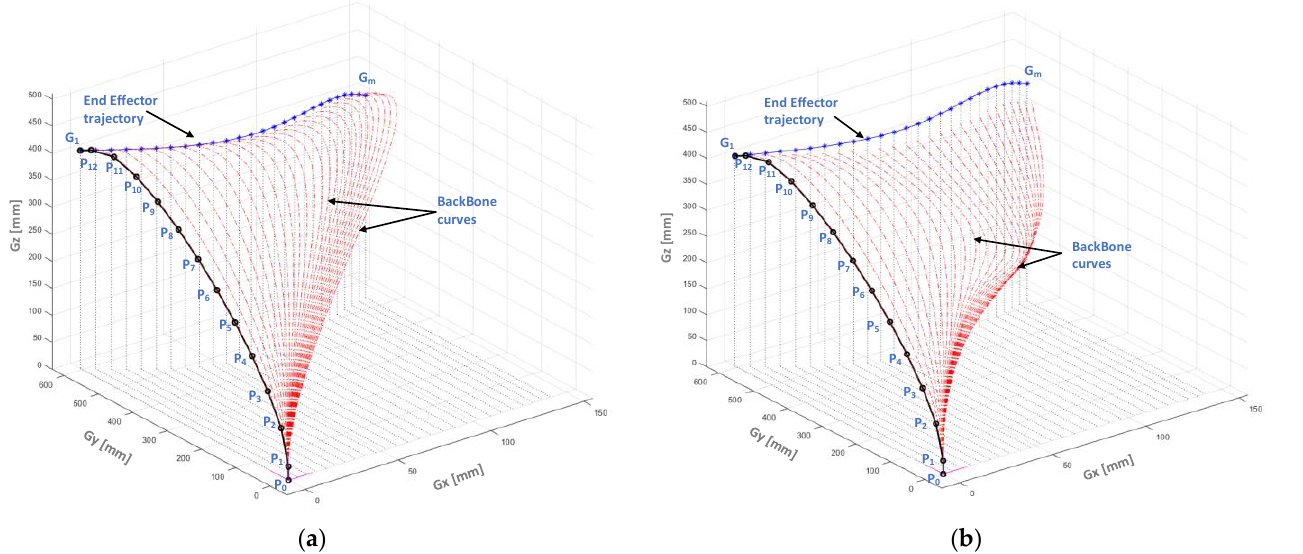
Figure 5. Calculation of the BC for a 3D imposed trajectory ( a ) constant orientation for the end-